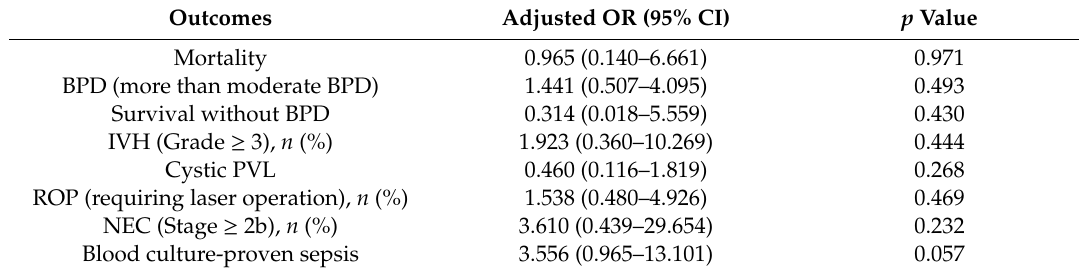
Table 4. Adjusted ORs * for risk of adverse outcomes by presence of Stage 3